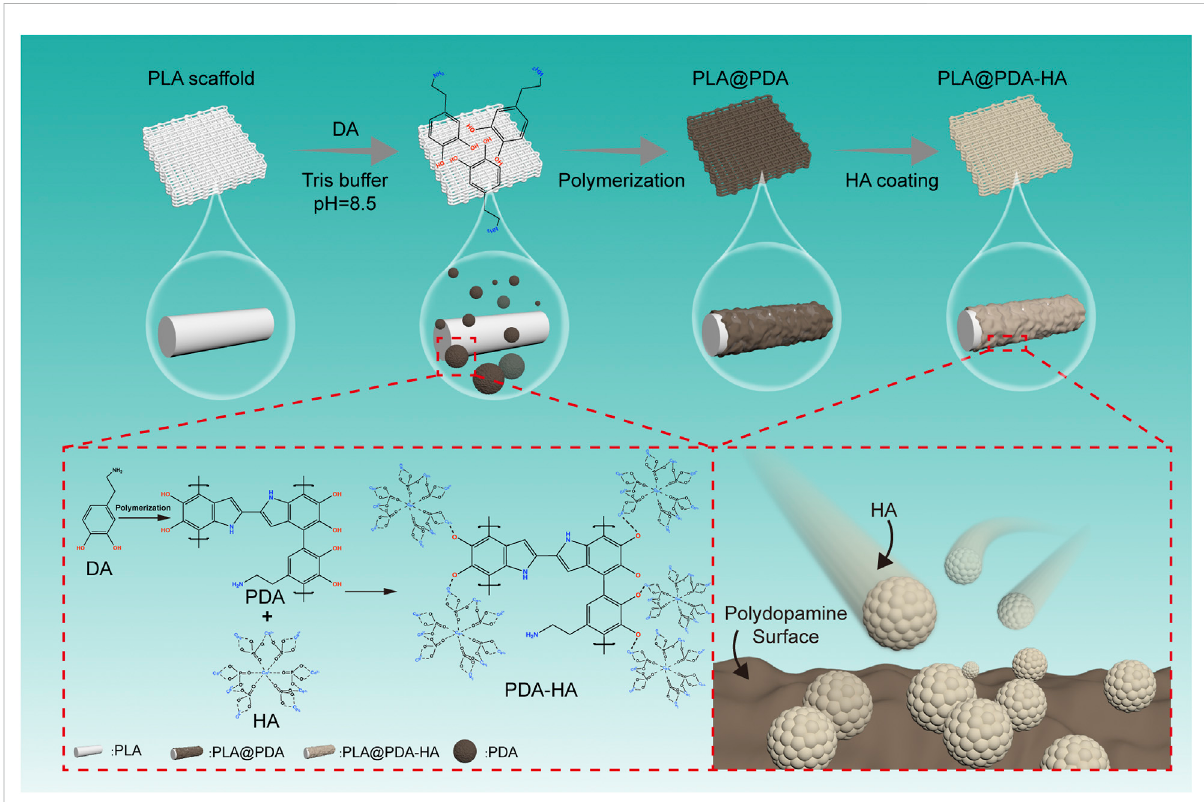
FIGURE 1 Schematic illustration of surface modi fi cation process of three-dimensional (3D)-printed PLA scaffolds. The PLA scaffold was fabricated with a rectangular porous structure using material extrusion-based 3D printing technology. Afterward, polydopamine was homogeneously coated onto the surface by immersing PLA scaffolds into the dopamine solution (tris buffer, pH = 8.5) and simultaneously stirring for 24 h, during which PDA was developedbyself-polymerizationofDAparticles.Furthermore,nHAparticlesweresuccessfullyimmobilizedontothesurfaceofas-synthesized PDA coatings via catechol functional groups. Finally, the nHA functionalized PLA scaffolds were